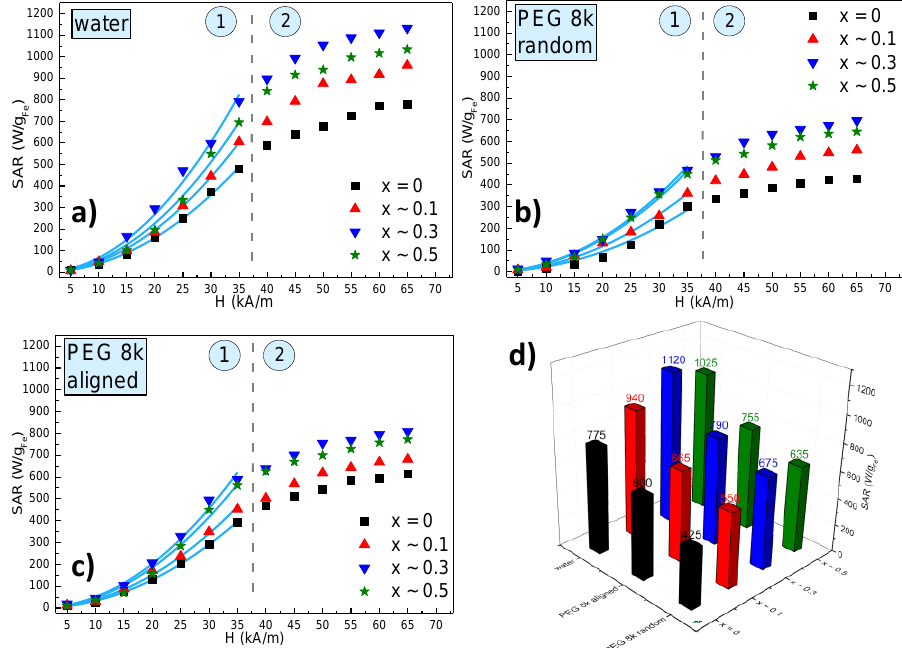
Figure 7. Specific absorption rate (SAR) dependence on the AMF amplitude (H) for Zn x Fe 3 − x O 4 MNPs (0 ≤ x < 0.5) ( a ) in water, ( b ) in solid polyethylene glycol 8000 (PEG 8k) with a random orientation and ( c ) in a solid PEG 8k pre-aligned parallel with alternating magnetic field directions. ( d ) The saturation values of SAR for all 4 samples in water and PEG 8k both in random and aligned organizations. The dashed green lines delimit the two regions of the SAR evolution with H, which are marked by the numbers 1 and 2. The continuous blue lines represent fittings with the parabolic dependence of SAR on H.